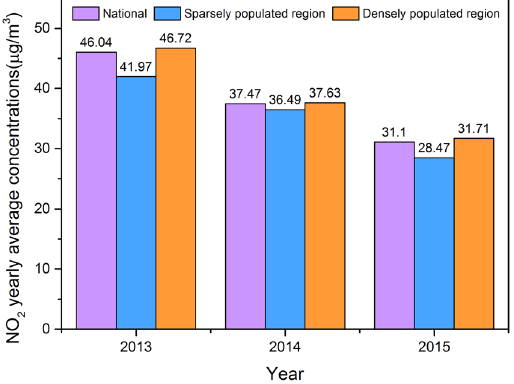
Figure 5. The annual averaged NO 2 concentrations of 2013–2015.